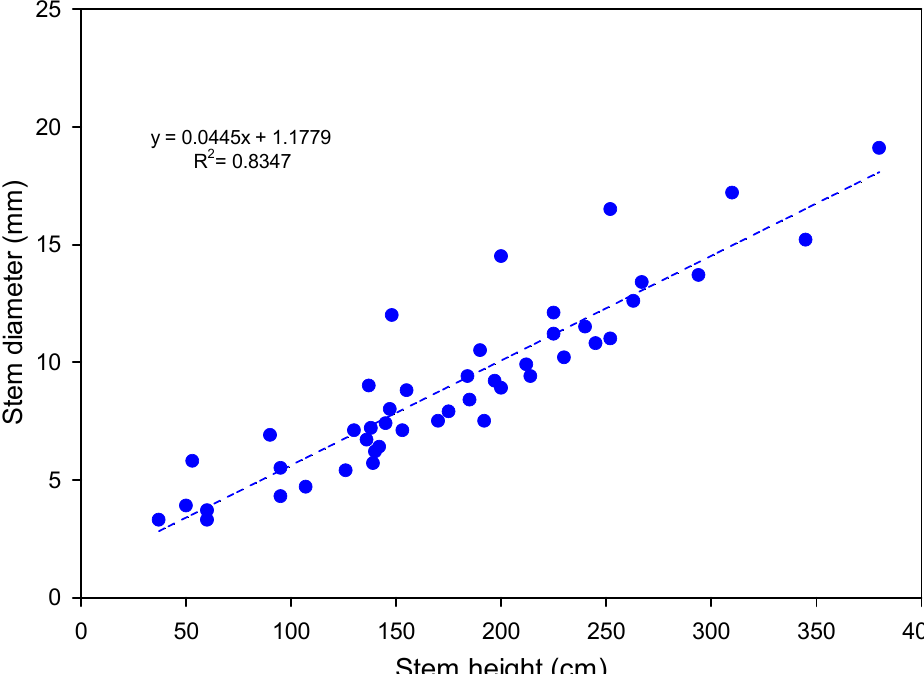
Figure 4. Correlation between height and basal diameter of the main stem measured on Figure4. Correlationbetweenheightandbasaldiameterofthemainstemmeasuredonsemi-hydroponic semi-hydroponic grown Arundo donax plants. grown Arundo donax